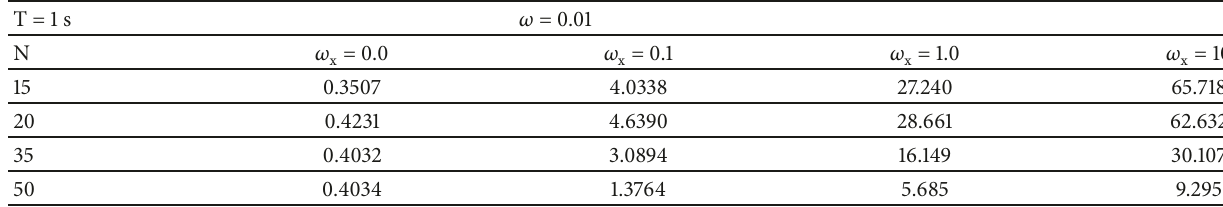
Table 1: IAE quality measure for system (8a).